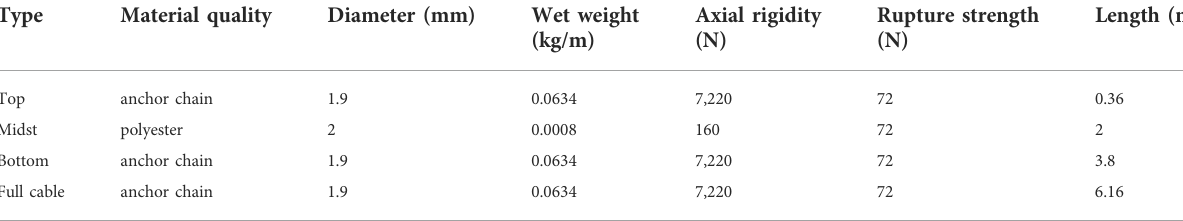
TABLE 4 Model parameters of hybrid mooring cable scheme. Model parameters of full anchor chain